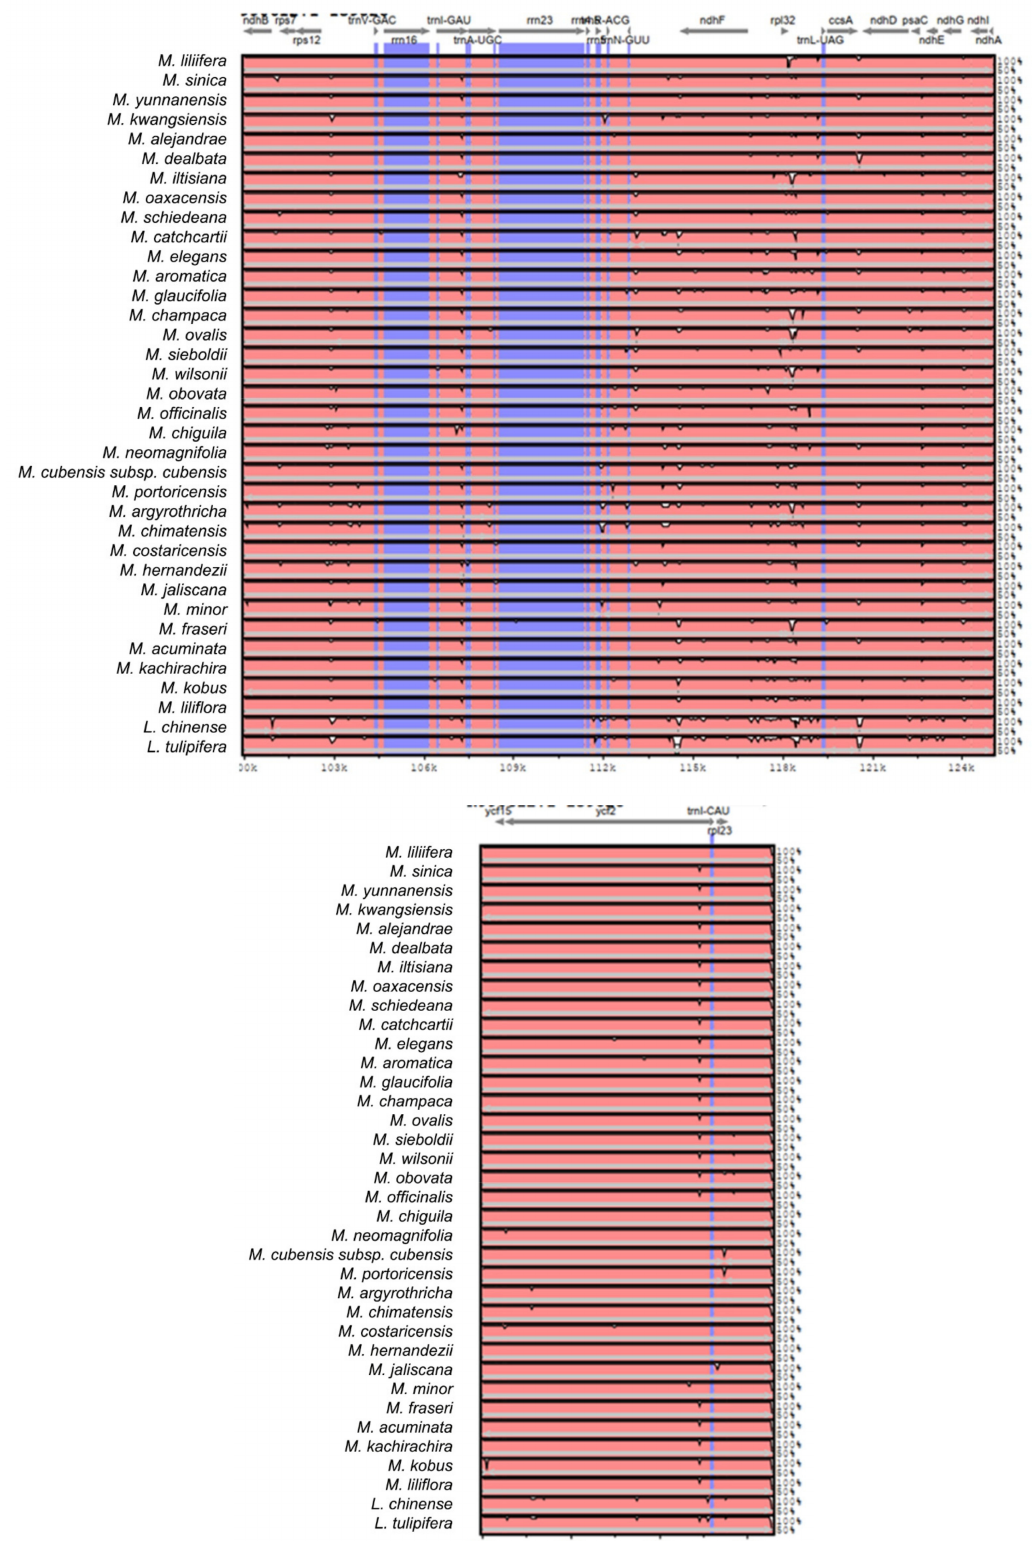
Figure A2. Sequence identity plot produced by Shuffle-LAGAN alignment in mVista comparing 37 Magnolia species; Magnolia coco was used as reference. Grey arrows represent genes with their orientation. Pink areas are conserved non-coding sequences (CNS). Blue areas are exons. The Y-axis represents the percentage of conservation of each species against the